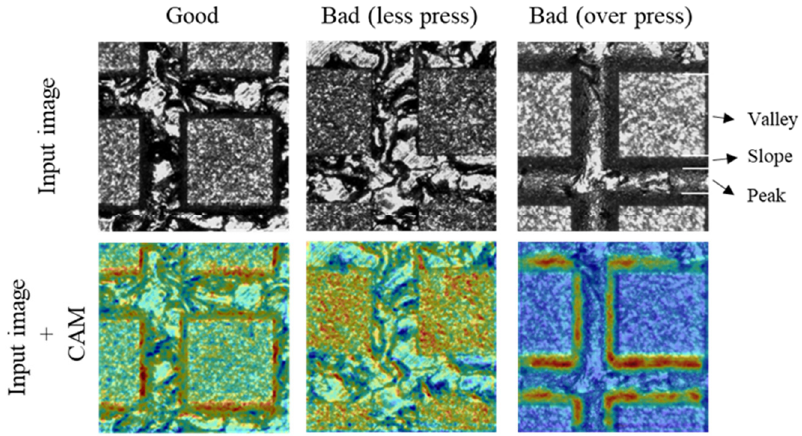
Figure 11. Results of CNN classification using the groove pattern with 1000 µm pitch.